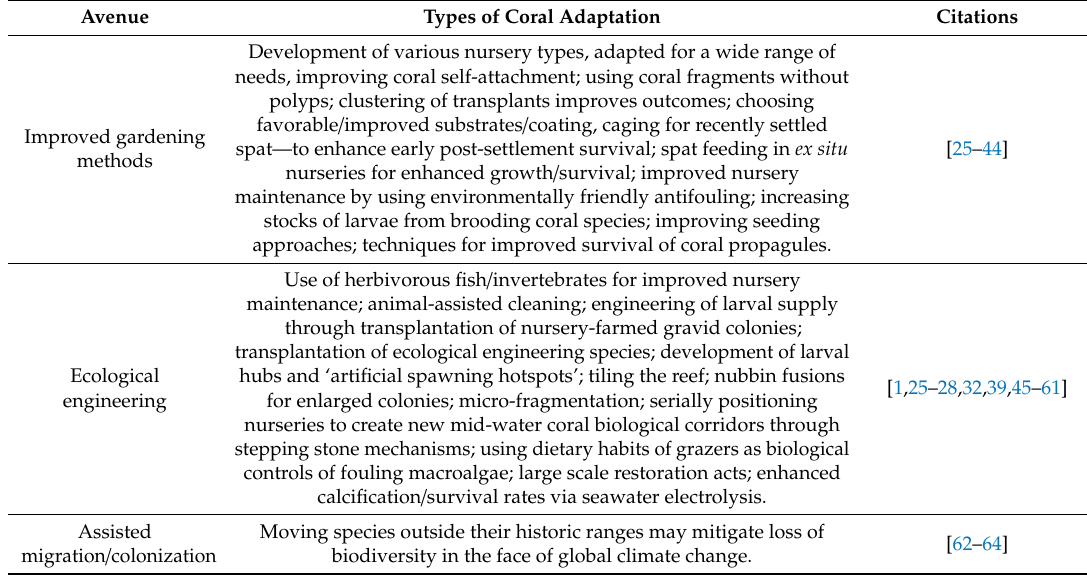
Table 1. The seven major research avenues added to the gardening approach for the creation of a climate adaptation toolkit (chosen references from the